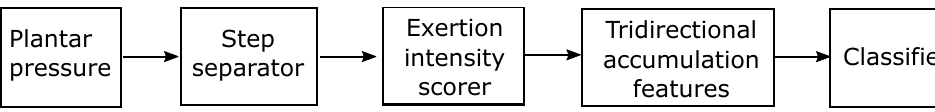
Figure 2. TAWA-based method of activity recognition and pedestrian